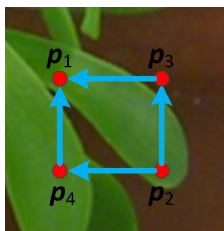
Figure 3. Paths Described by Horizontal/Vertical